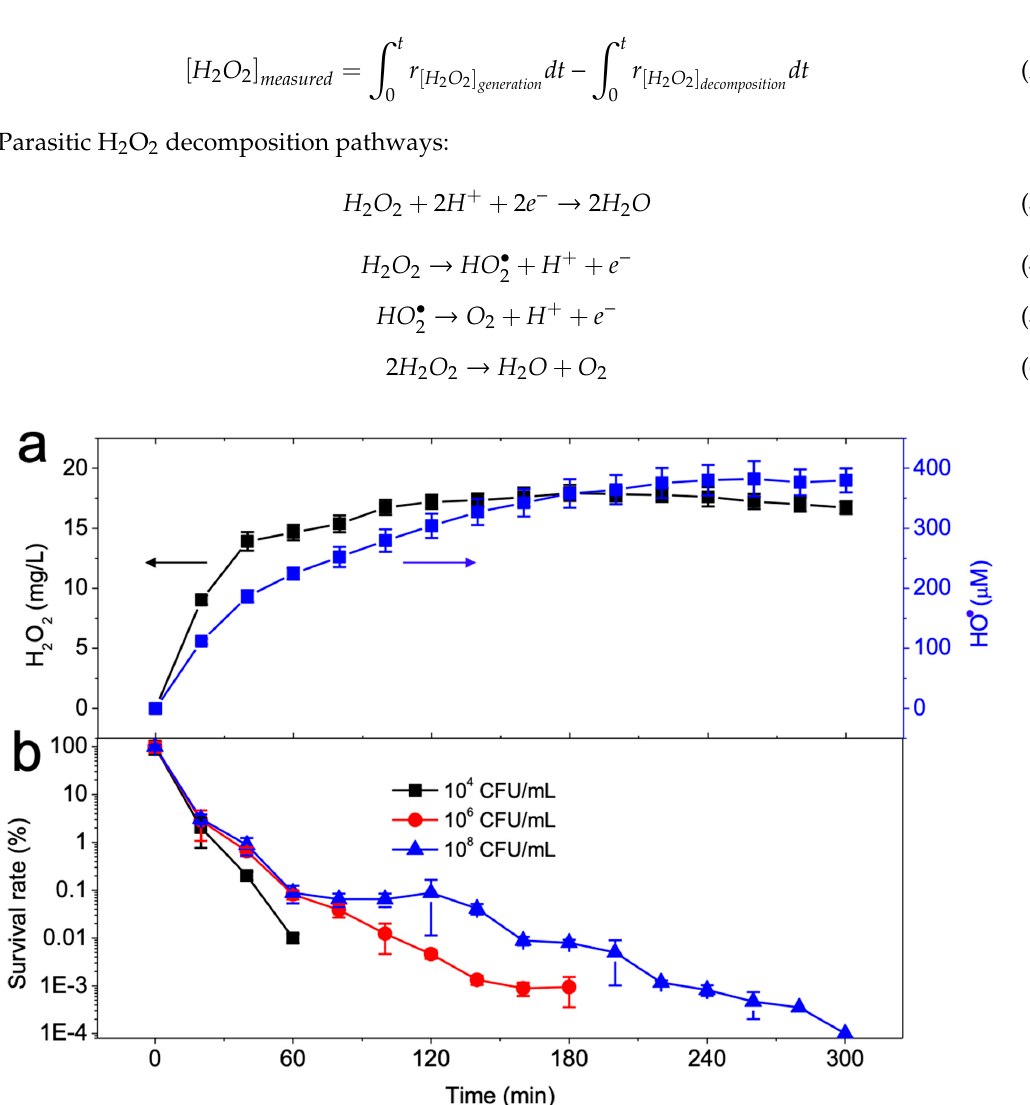
Figure 4. ( a ) Yields of hydrogen peroxide and hydroxyl radical by electro-Fenton process during 300 min reaction and ( b ) bacterial disinfection performances at different bacteria